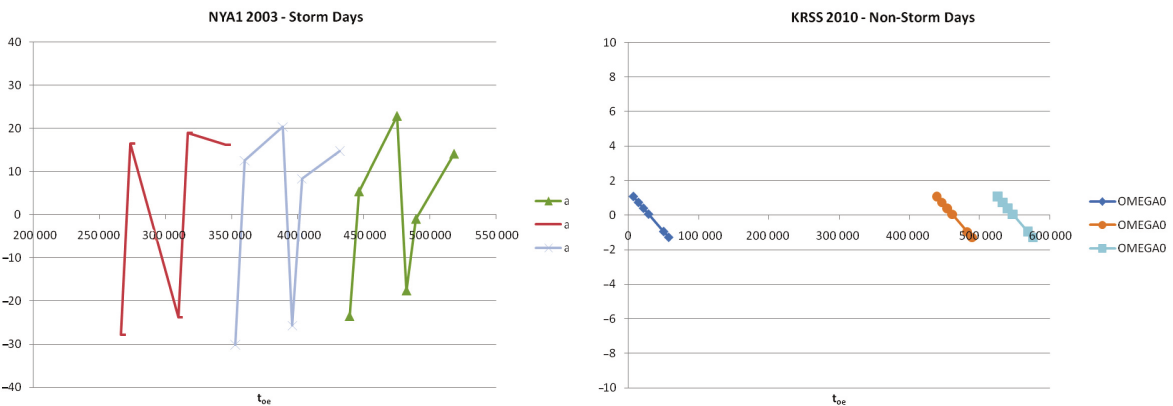
Fig. 11. Right ascension of the ascending node during three stormless days in 2010 using cPOS stations (KRSS)